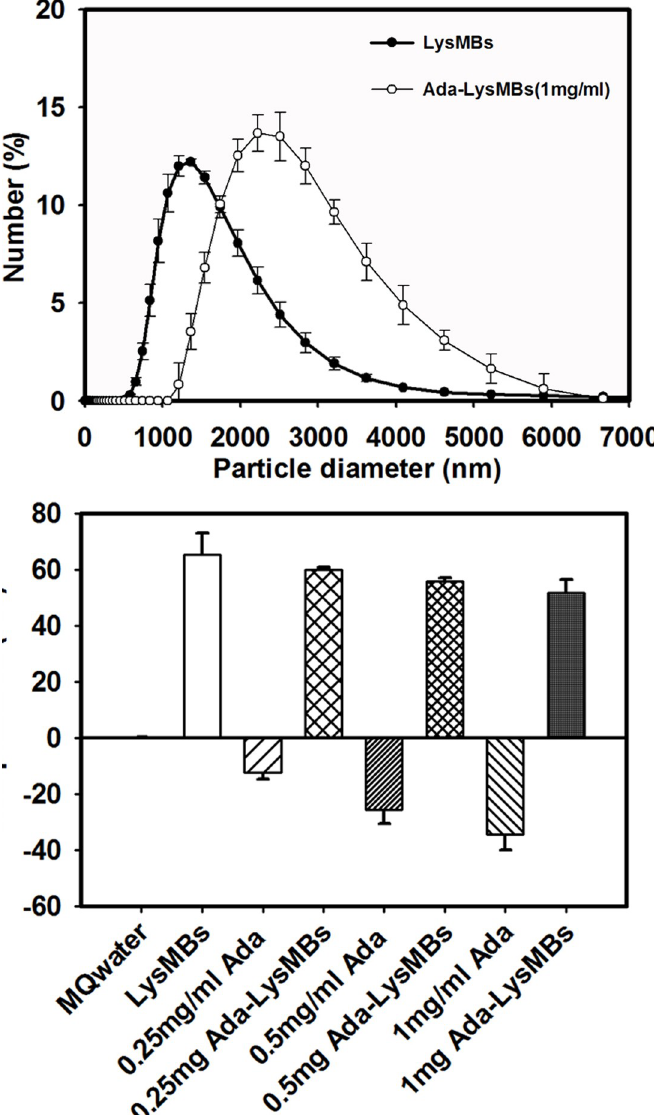
Fig 2. Quantification of the size distributions (A) and zeta potentials (B) of LysMBs and Ada-LysMBs.